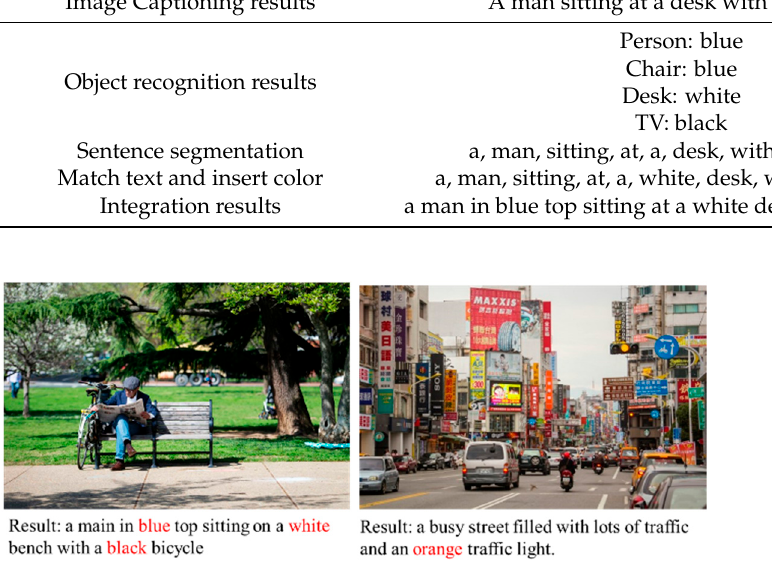
Figure 15. Integration results of Figure 13.